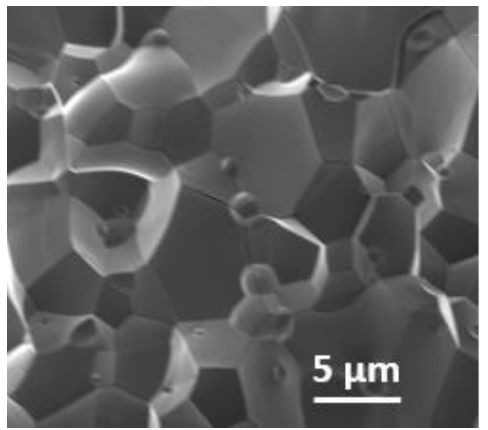
Figure 2. SEM image of Ca 2 Fe 2 O 5.